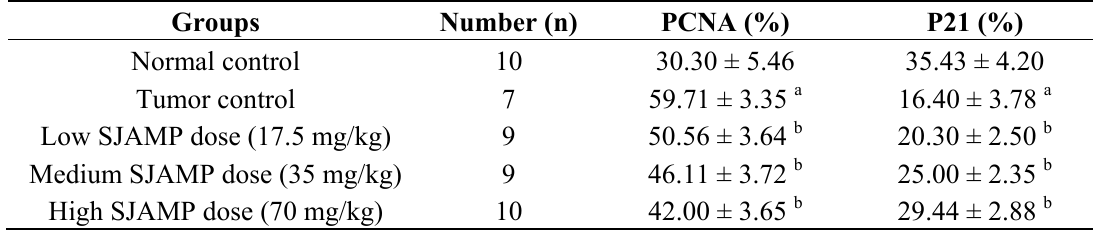
Table 4. Effect of SJAMP on PCNA labeling index and p21-positive cells in rats with DEN-induced HCC ( x ± SD).